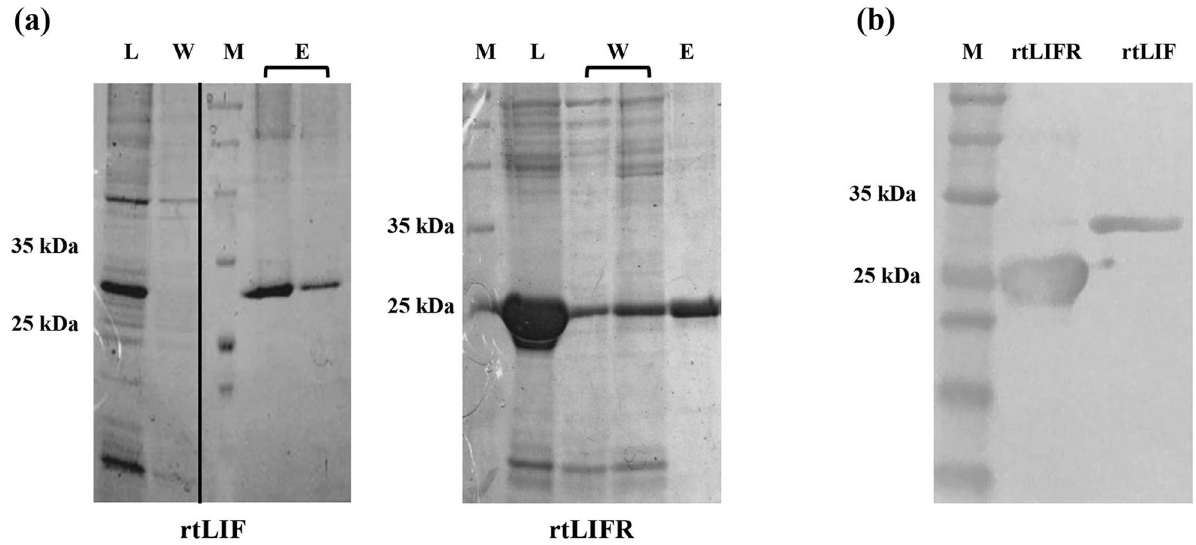
Figure 2. Expression of rtLIF and rtLIFR proteins in E. coli . ( a ) SDS-PAGE of induced bacteria lysates followed by Ni-column purification showed the rtLIF and rtLIFR protein bands with the molecular weights of 30 and 25 kDa, respectively. M: protein size marker; L: bacterial lysate; W: wash; E: elution. ( b ) Western blotting using histidine-tag antibody confirmed expression of both proteins. Full-length of gels and blot are presented in supplementary